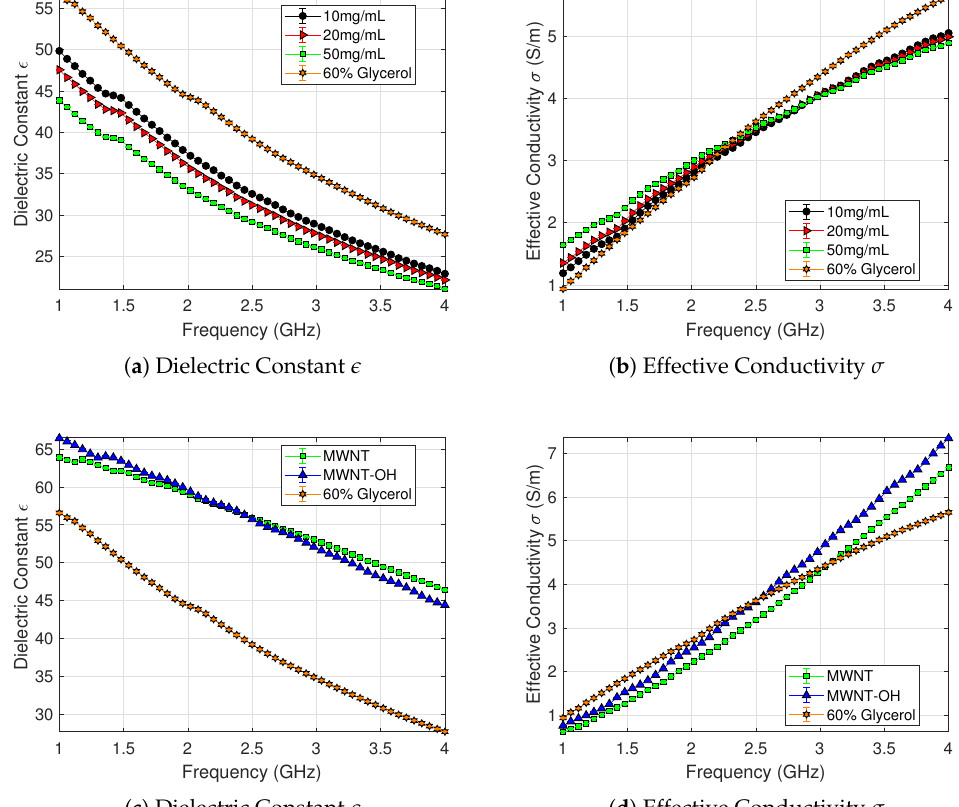
Figure 3. Microwave dielectric properties of the target materials used for dielectric contrast enhancement. ( a ) Dielectric constant, and ( b ) effective conductivity of 60% glycerol mixed with a range (10 mg/mL–50 mg/mL) of salt concentrations. ( c ) Dielectric constant, and ( d ) and effective conductivity of 60% glycerol suspensions with basic (MWNT) and functionalised (MWNT-OH) multi-walled carbon nanotubes at 2 mg/mL. The average values over 10 measurements (n = 10) of each salt solution and NP dispersion samples are plotted with ± 1 σ std